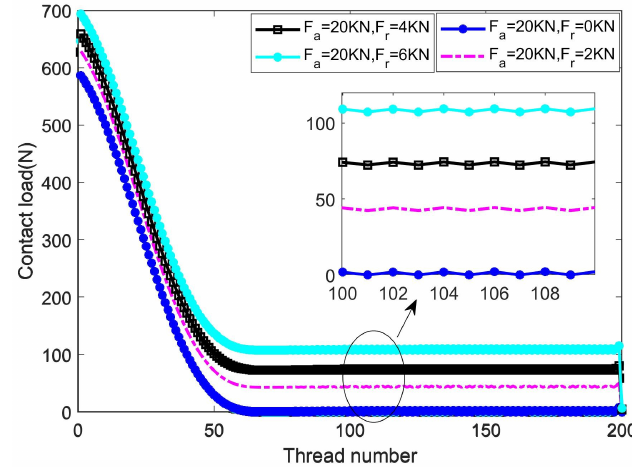
Figure 18. The effects of different radial loads in case 1.